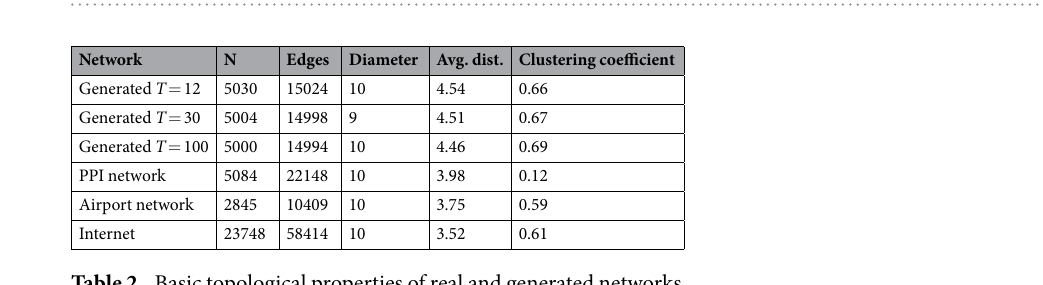
Table 2. Basic topological properties of real and generated